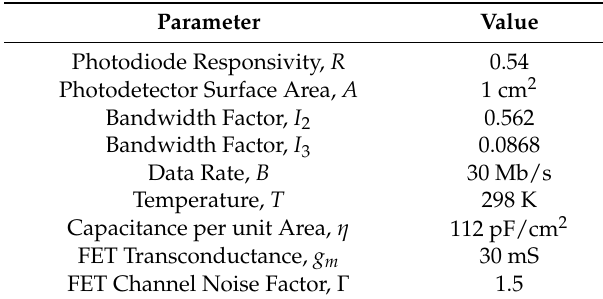
Table 6. BER parameters